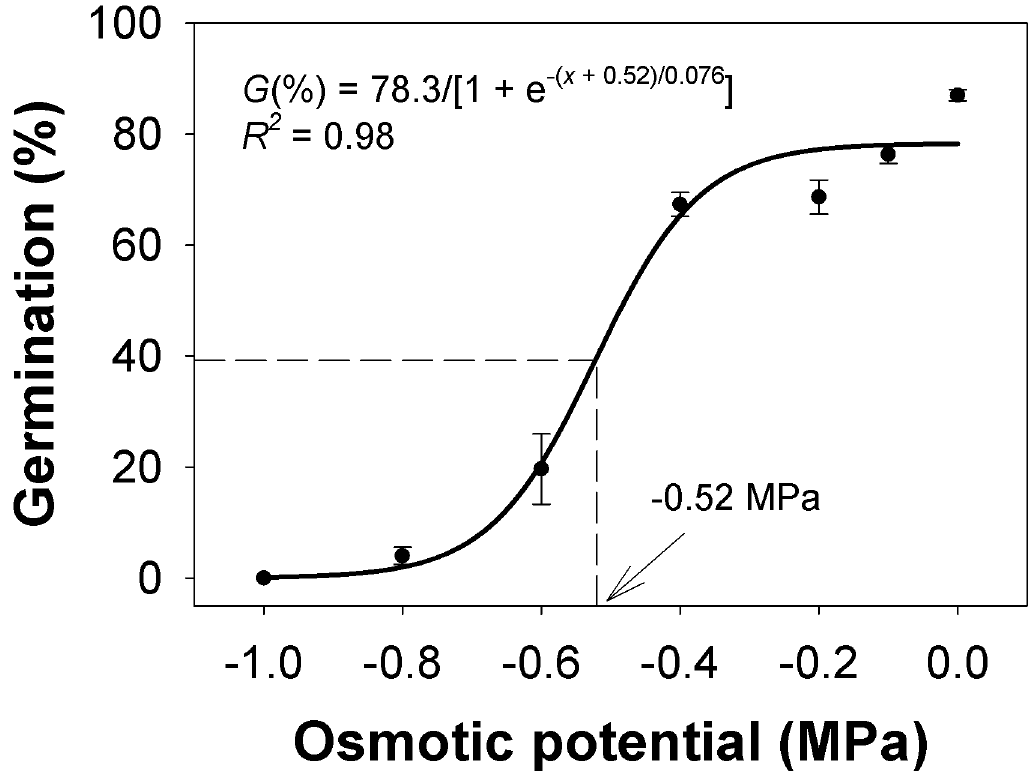
Fig 3. Effect of osmotic potential on seed germination of Chloristruncata after 21 d of incubation at 25/15˚C day/night temperature. The line represents a three-parameter sigmoid model fitted to the data. The arrow shows the osmotic potential required to inhibit 50% germination. Vertical bars represent standard error of